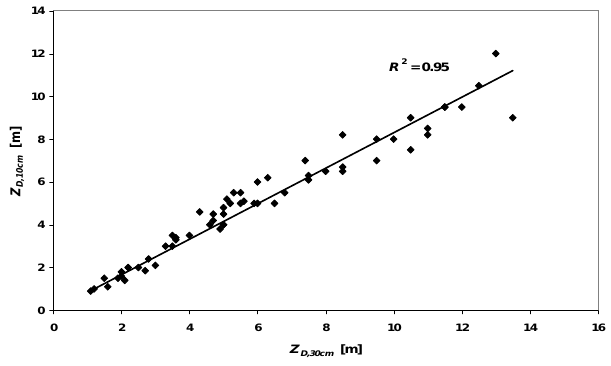
Fig. 5. All naked eye and colour filter observations of Z D,10 cm,tel with a telescope as a function of Z D,10 cm without a telescope. The best-fit line through the origin is the function Z D,10 cm,tel = 1 . 19 Z D,10 cm